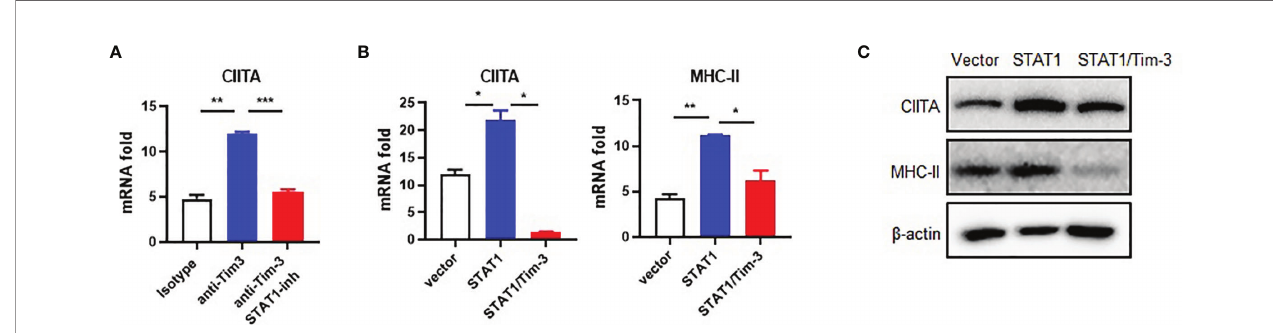
FIGURE 3 | Tim-3 signaling inhibits CIITA expression through STAT1 in macrophages. (A) RAW264.7 cells were incubated with 20 m g/ml anti-Tim-3 antibody or control antibody for 24 h in the presence of the STAT1 inhibitor fl udarabine (10 m M) or dimethyl sulfoxide control and then were collected, and CIITA mRNA levels were examined by RT-PCR (mean ± SD, n = 3). (B) HEK-293T cells were transfected with STAT1 plasmid, with or without Tim-3 plasmid for 48 h, and the mRNA levels of CIITA (mean ± SD, n = 3) and MHC-II (mean ± SD, n = 3) were detected. (C) HEK-293T cells were transfected with STAT1 plasmid, with or without Tim-3 plasmid and lysed, and the protein levels of CIITA and MHC-II were analyzed at 48 h (*p < 0.05; **p < 0.01; ***p